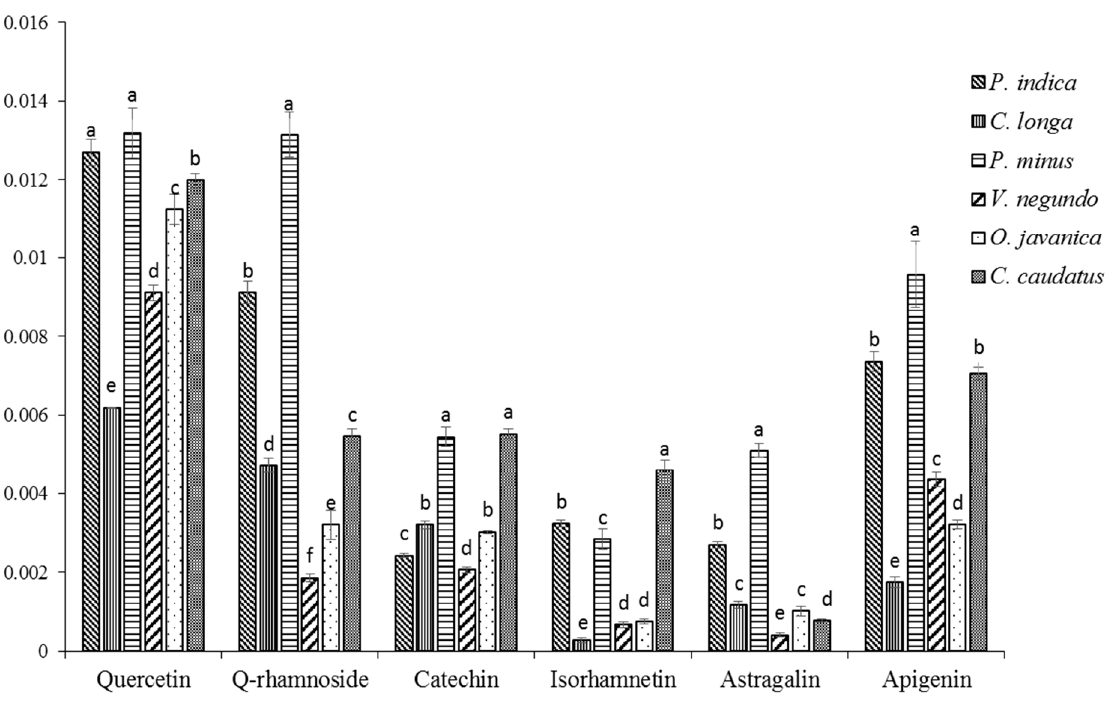
Figure 6. Relative quantification of identified metabolites in leaves of selected herbs based on the mean peak area of 1 H-NMR signals. Means with the same letters are not significantly different ( p > 0.05) within a metabolite.